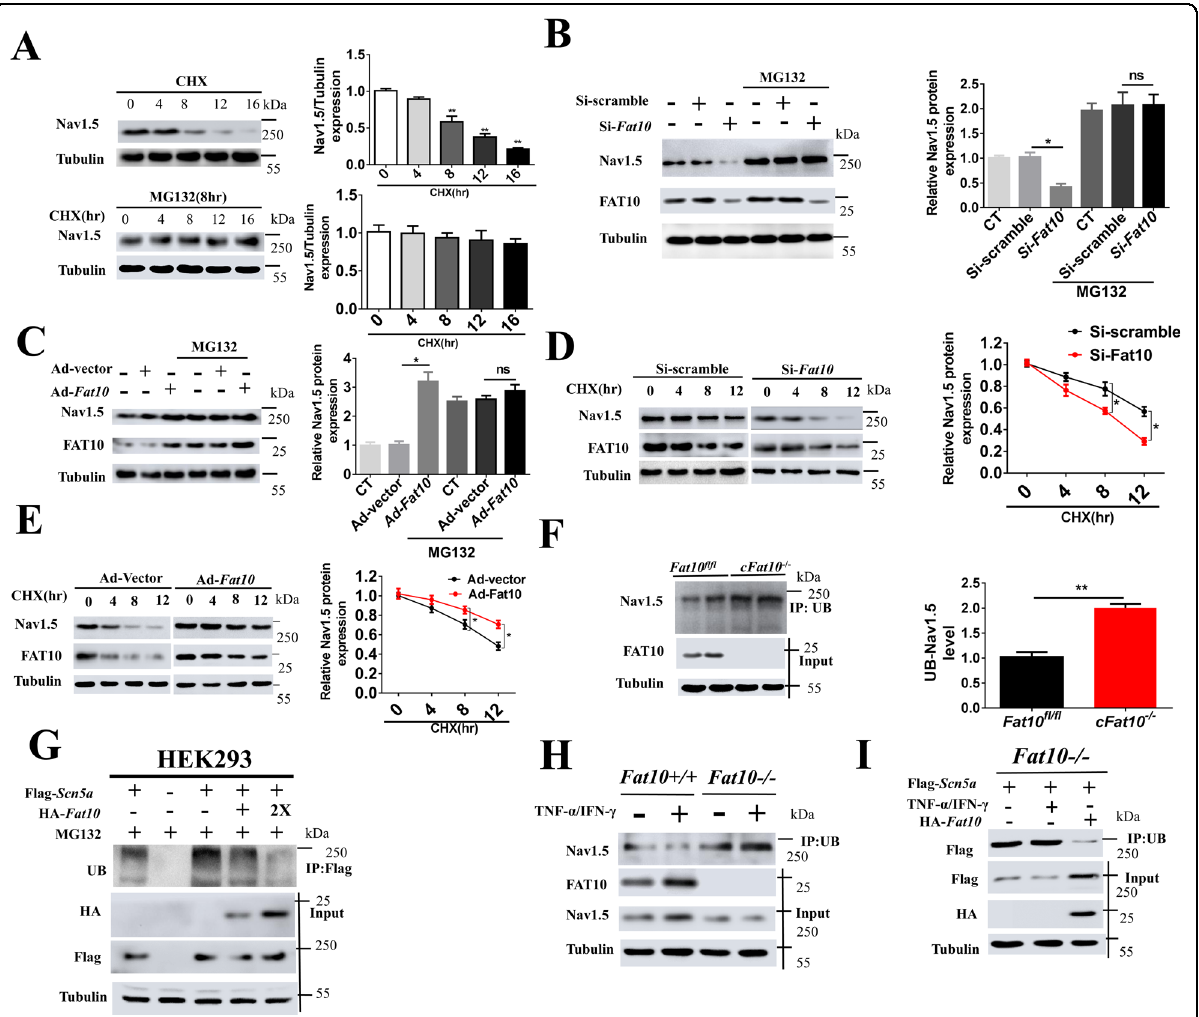
Fig. 5 FAT10 stabilizes Nav1.5 expression in cardiomyocytes by inhibiting ubiquitination. A Representative immunoblots (left) and quantitative assessment of the protein (right) levels of Nav1.5 in NRCMs treated with cycloheximide (CHX, 20 μ M) or MG132 (15 μ M) for the indicated times. * p < 0.05 and ** p < 0.01 vs. treatment in the 0 h group. B , C Representative immunoblots or quantitative data of Nav1.5 expression in NRCMs after adenoviral knockdown ( B ) or overexpression ( C ) of Fat10 . Cells were treated with or without MG132 (* p < 0.05). D Western blotting was performed to detect the expression of FAT10 and Nav1.5 in NRCMs with or without FAT10 knockdown (* p < 0.05) treated with CHX. E Western blotting was performed to detect the expression of FAT10 and Nav1.5 in NRCMs with or without FAT10 overexpression treated with CHX (* p < 0.05). F Representative immunoblots (left) and quantitative data (right) of Nav1.5 ubiquitination levels after immunoprecipitation of Nav1.5 from cultured cardiomyocytes isolated after MG132 treatment for 8 h (* p < 0.05). G Representative immunoblots of the Nav1.5 ubiquitination levels in HEK293 cells transfected with the indicated plasmid DNA. Cells in each group were treated with MG132. H Representative immunoblots of the Nav1.5 ubiquitination levels in Fat10 + / + and Fat10 − / − HEK293 cells treated with or without TNF- α /IFN- γ . I Representative immunoblots of the Nav1.5 ubiquitination levels in the indicated groups of Fat10 − / − HEK293 cells. All results are expressed as the mean ± SEM of independent